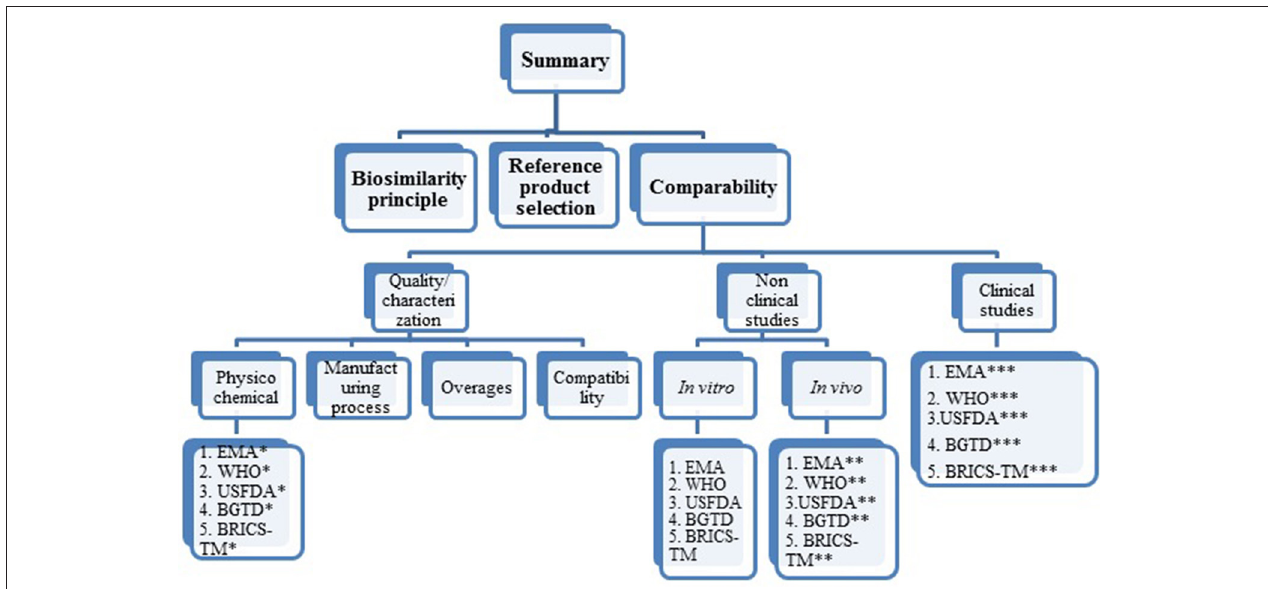
FIGURE 1 | Structure of data presentation in result section. *Under each agency the psychochemical requirements covered are mAb structure, immunological properties, biological activity purity impurity and contaminants cell lines quantity,specifications. **Under each agency, the in vivo (non-clinical) studies requirements covered are pharmacokinetics, pharmacodynamics, immunogenicity, safety pharmacology, toxicology, carcinogenicity, local tolerance. ***Under each agency the clinical requirements covered are pharmacokinetics, clinical efficacy, clinical safety, extrapolation to other indications, pharmacovigilance, risk management